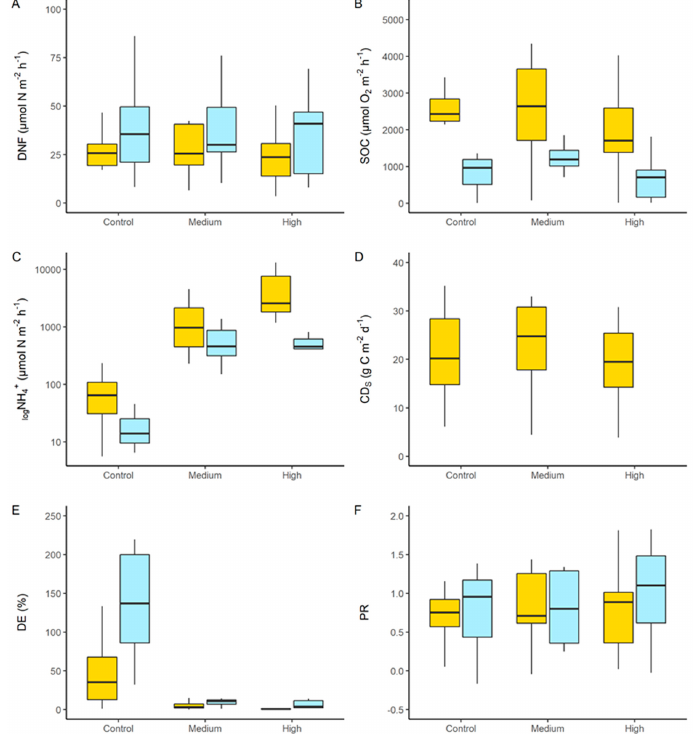
Figure 2. Inorganic nitrogen ( A , C , E ) and carbon related ( B , D , F ) fluxes and indices during summer (yellow, n = 18) and winter (blue, n = 9) as a function of nutrient enrichment treatment. Boxes represent the 25th and 75th percentiles, and whiskers are the 5th and 95th percentiles. A solid line within each box denotes the median. Note the log 10 scale of the y-axis in panel C. DNF = net denitrification rate; NH 4+ = NH 4+ efflux; DE = denitrification efficiency; SOC = sediment oxygen consumption; CD S = carbon degradation rate at the sediment surface; PR = photosynthesis respiration ratio.